Question: Briefly state, in one sentence, what is plotted here.
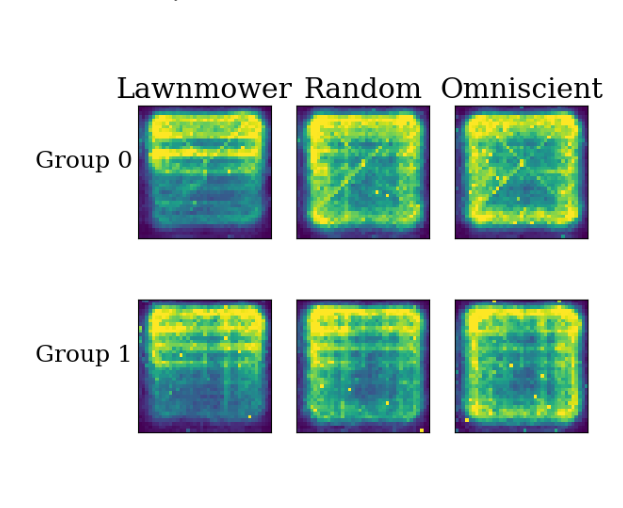
Answer: A heatmap of the subject searched area with the initial position removed. The Lawnmower strategy was more predictable and resulted in subjects avoiding the autonomous searcher’s area. The Random and Omniscient strategies were more likely to search the center areas, resulting in subjects searching the exterior of the grid more often.